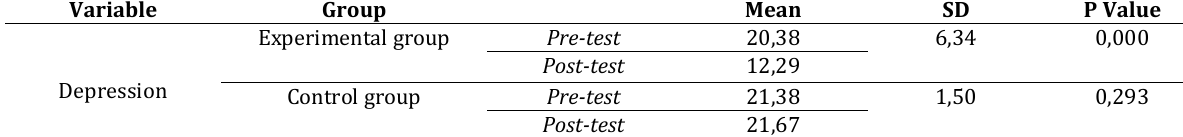
Table 2. Difference in BDI Scores on Pre-test and Post-test of Experimental Group and Control Group Variable